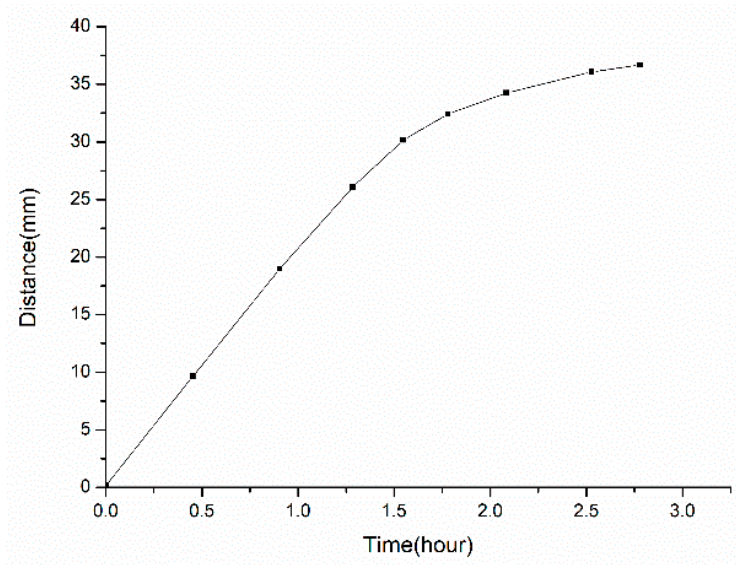
Figure 8. The penetration depth of the fracturing fluid versus time for core 96.